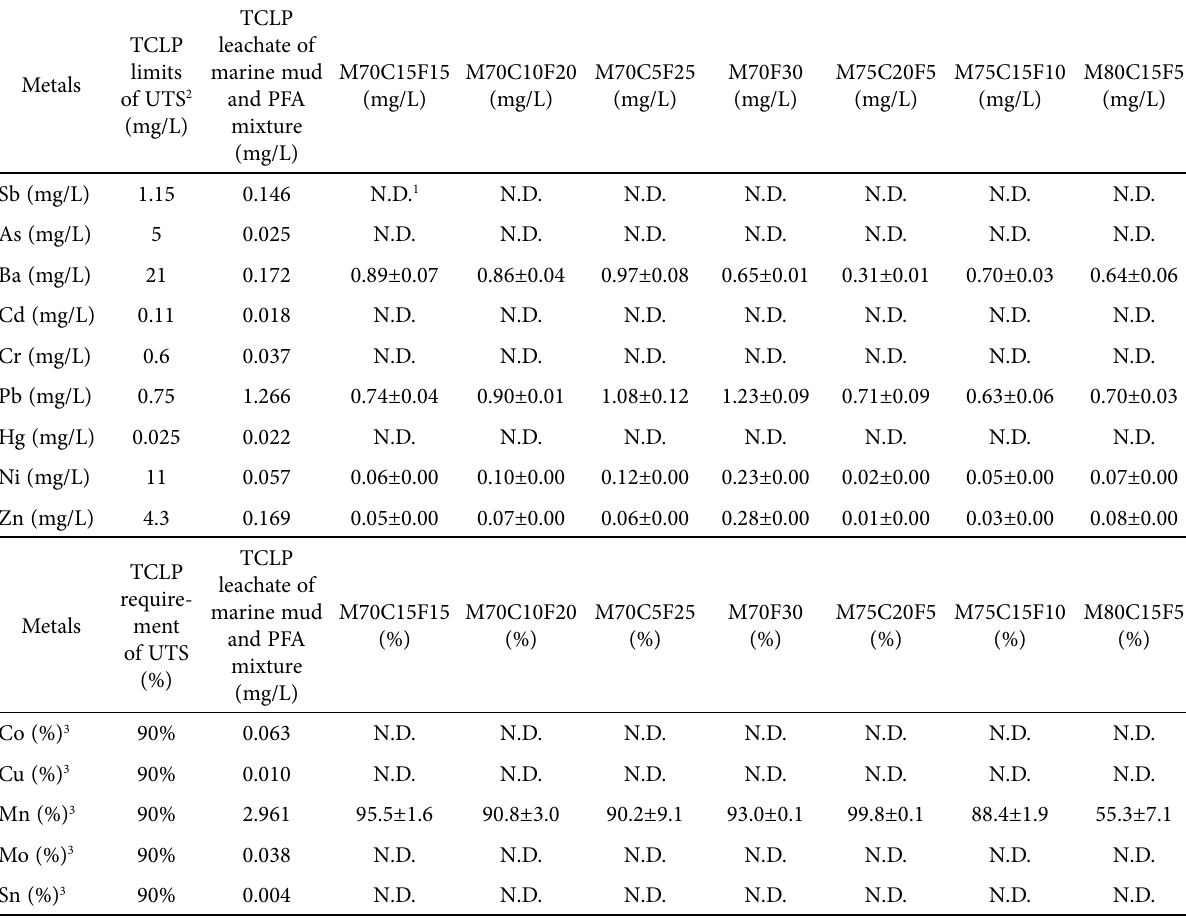
Table 4. TCLP results of S/S treated marine mud after 28 days of